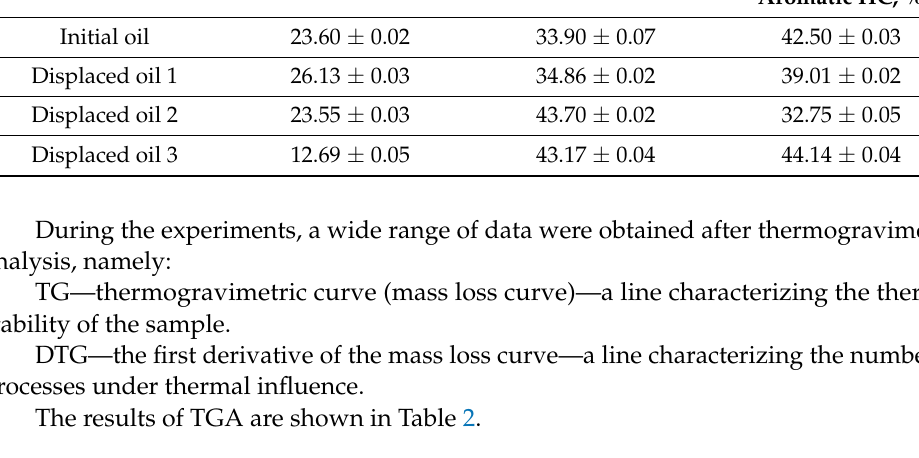
Table 2. The content of organic matter and coke after